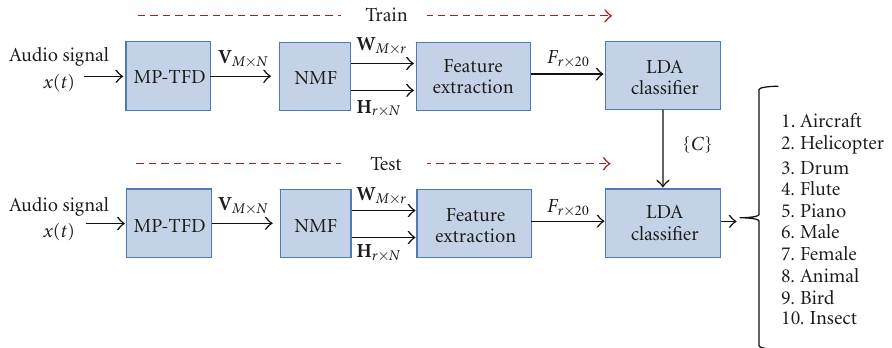
Figure 2: This block diagram represents the TFM quantification technique. In this approach, first the TFD ( V K × N ) of a signal ( x ( t )) is estimated. Then a MD technique decomposes the estimated TF matrix into r bases components ( W K × r and H r × N ). Finally, a discriminant and representative feature vector F is extracted from each decomposed component.